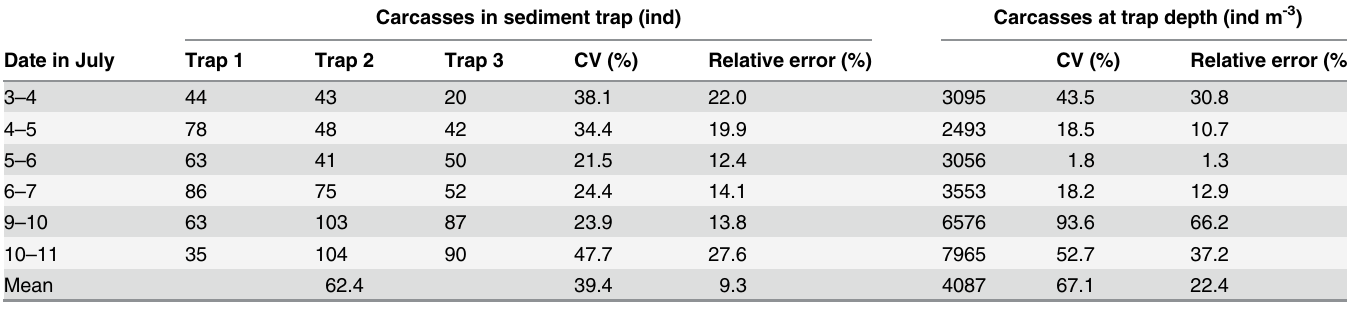
Table 1. Number of Bosmina longirostris carcasses accumulated in sediment traps per day ( Y in Eq 6) and carcass abundances at trap depth (12 m, average of 2 – 3 samples taken at the beginning and at the end of daily trap exposure; y * in Eq 6) in Lake Stechlin. Carcasses in sediment trap (ind) Carcasses at trap depth (ind m -3